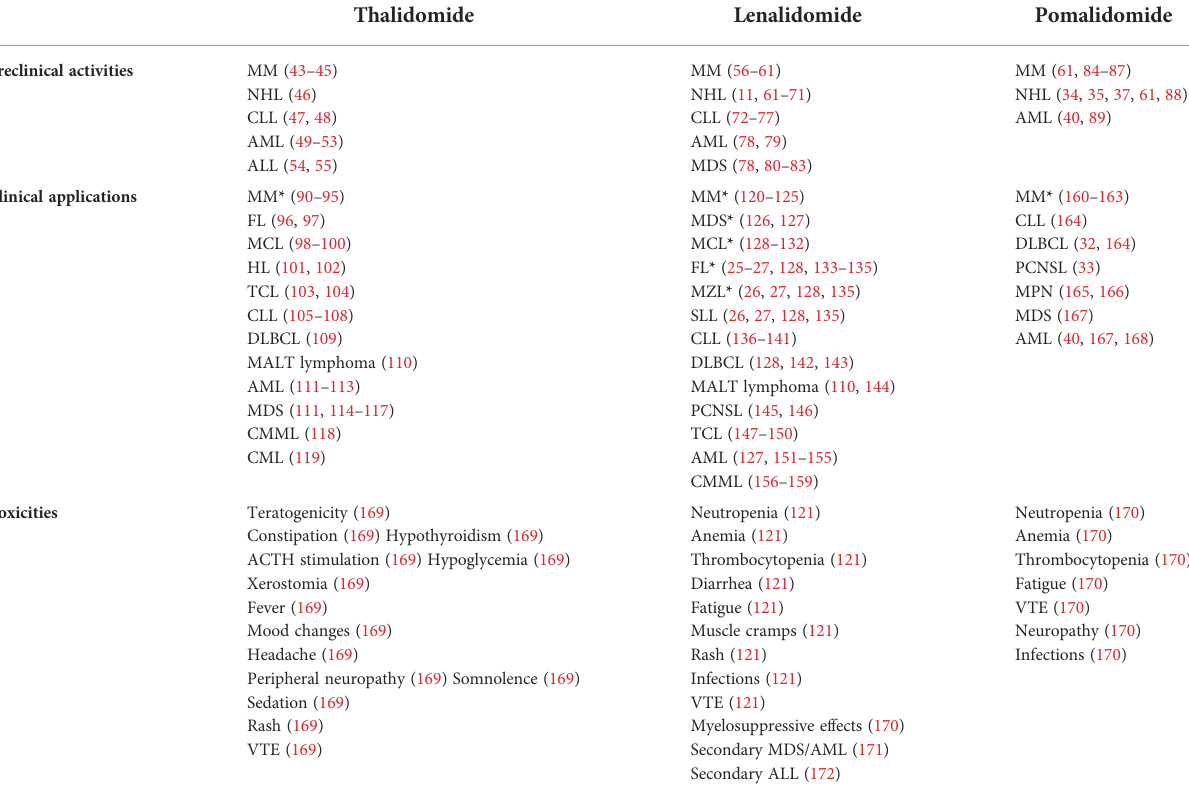
TABLE 1 Applications of thalidomide analogues in hematologic malignancies and reported